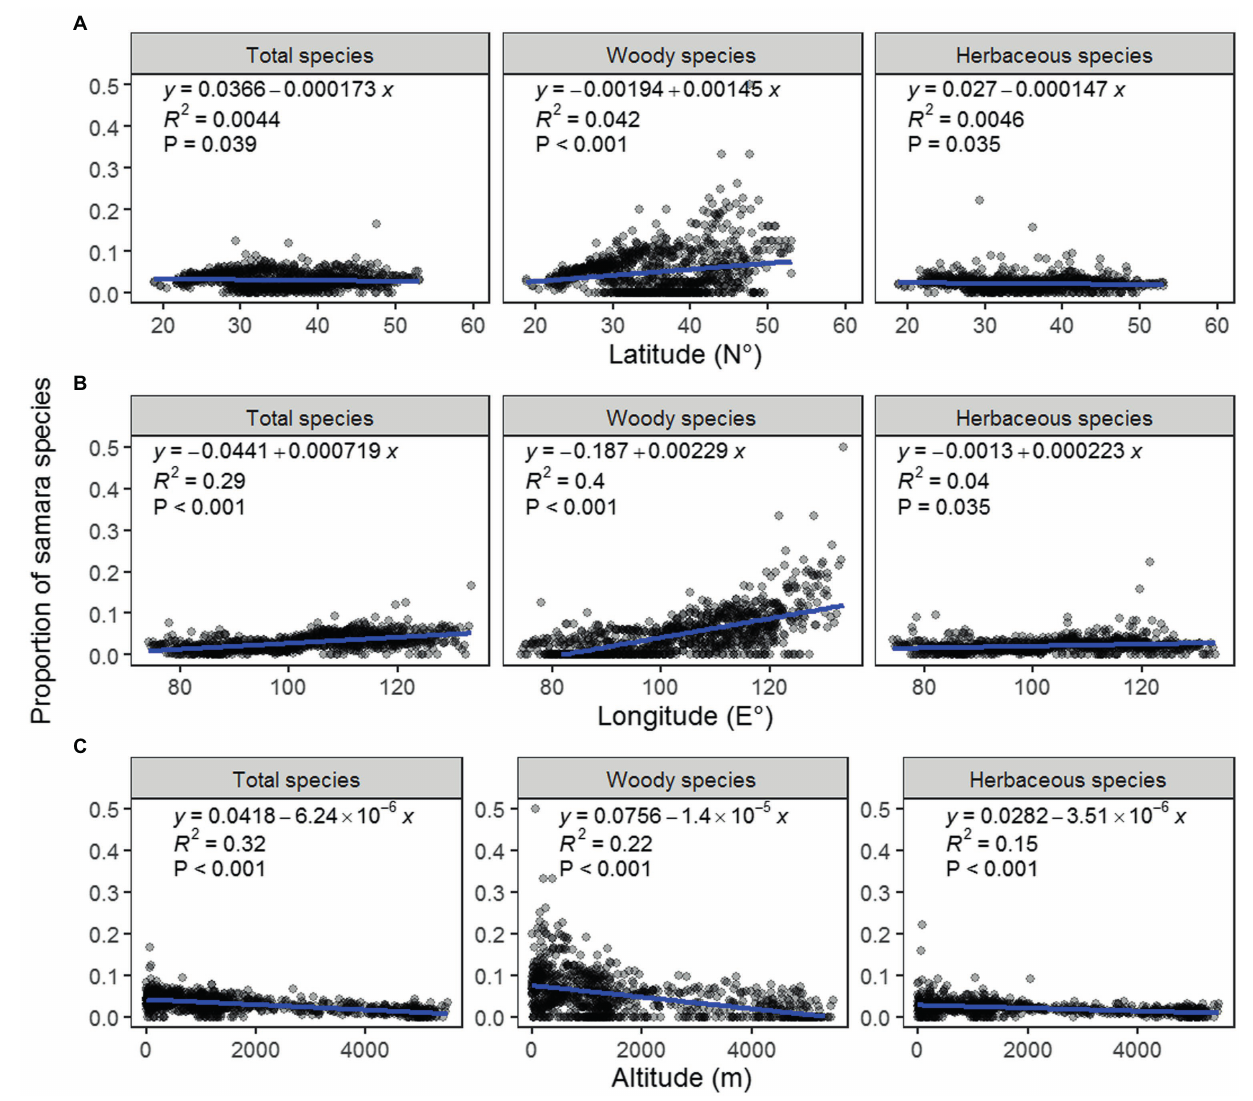
FIGURE 4 | Regression analysis between the proportion of total (left), woody (middle), and herbaceous (right) samara species and latitude (A) , longitude (B) , and altitude (C)